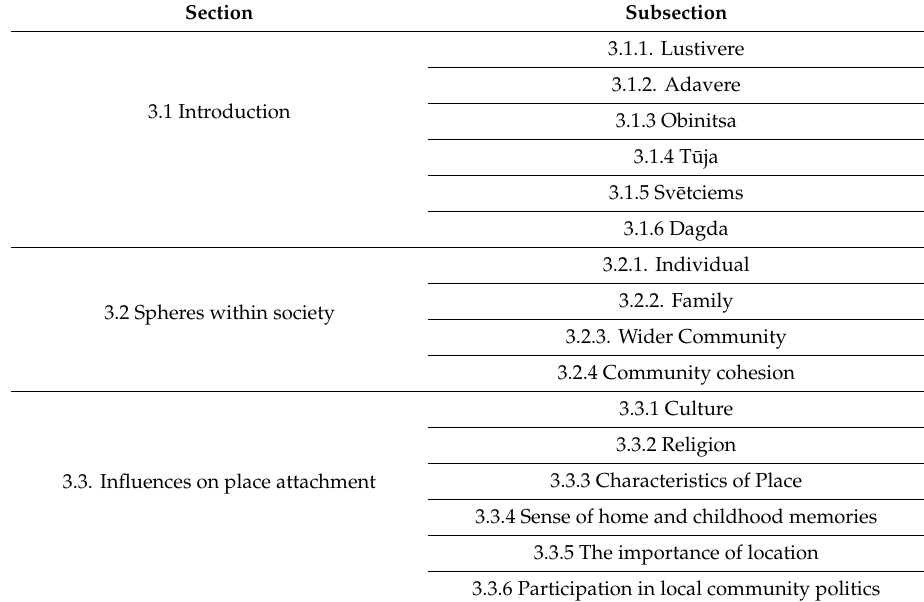
Table 2. Details of the following results sections and